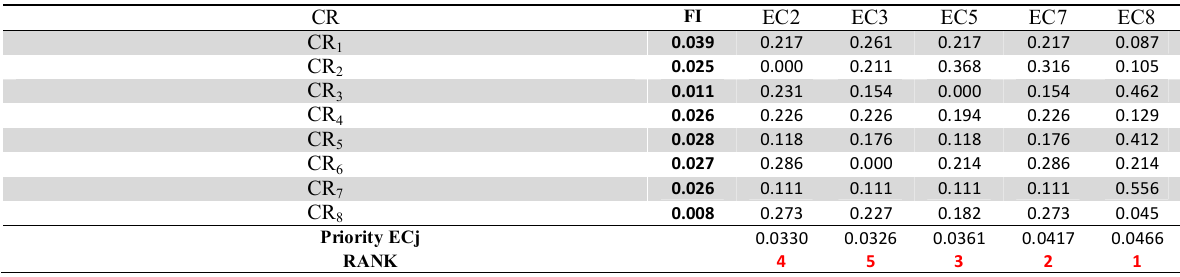
Fig. 7. Simplified HoQ for Alternator